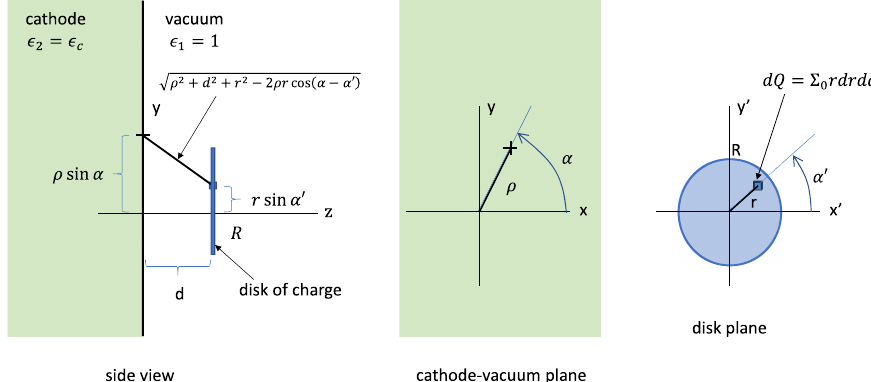
8. The geometry for calculating the polarization charge density on the cathode surface. The side view shows the distance between the point ( ρ ; α ) on the cathode surface and the point ( r; α 0 ) on the disk. The disk has a uniform surface charge density of Σ 0 . The polarization charge density at the point on the cathode is given by integrating the disk ’ s surface charge density over r and α 0 . The x axis is into the page in the side view, and the z axis is out of the page in the cathode-vacuum and disk plane